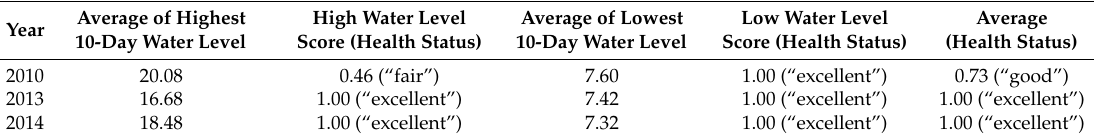
Table 1. Highest and lowest 10-day water levels in 2010, 2013, and